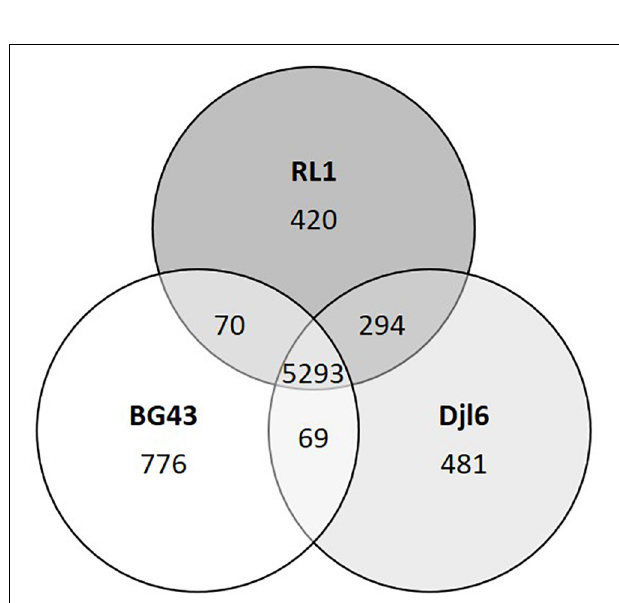
FIGURE 2 | Venn-diagram representing comparative distribution of shared genes between the genomes of RL1, djl6, and BG43. Data obtained with EDGAR Software. Unique genes or singletons are here genes without any hit (BLAST) against any other